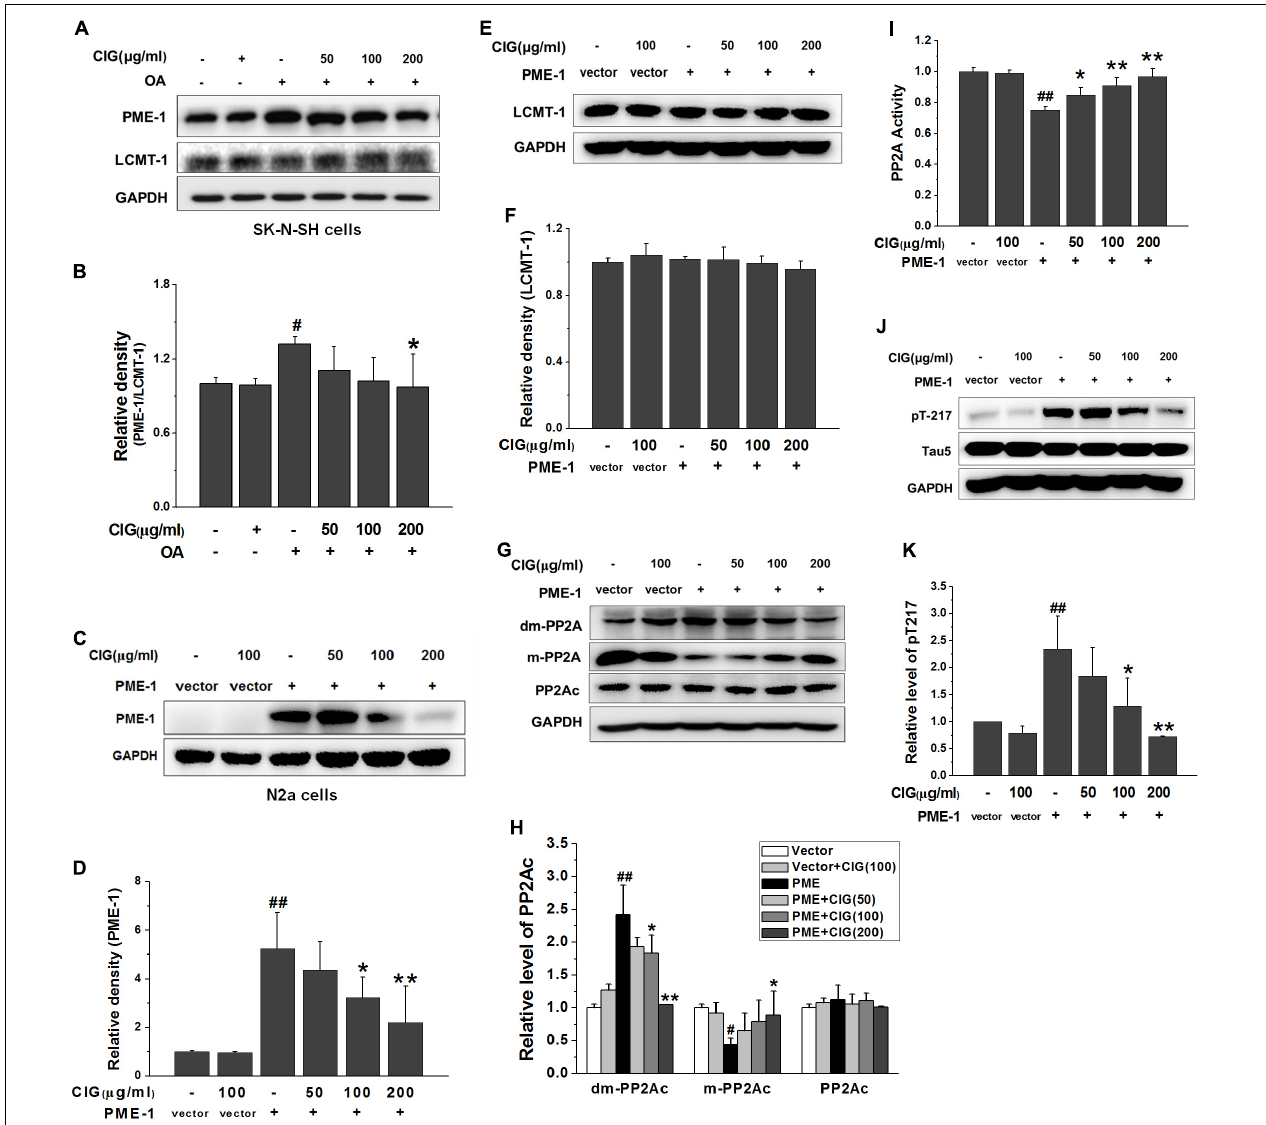
FIGURE 5 | Cornel iridoid glycoside inhibits demethylation of PP2Ac via decreasing PME-1. (A,B) The expression of PME-1 and LCMT-1 in OA-treated SK-N-SH cells, and the ratio of PME-1/LCMT-1. (C,D) The expression of PME-1 in mouse neuroblastoma N2a cells transduced with PME-1 genetic materials delivered by recombined lentivirus vector. CIG was incubated with the transduced cells for 24 h. (E,F) The expression of LCMT-1 in N2a cells transduced with PME-1 genetic materials. (G,H) The expression of demethylated PP2Ac (dm-PP2Ac) and methylated PP2Ac (m-PP2Ac). (I) The activity of PP2A measured by a biochemical assay, n = 6 per group. (J,K) The phosphorylation of tau at Thr217 (pT217). GAPDH was used as an internal control, and the expression level of control group was set as 100%. Data are expressed as mean ± SD; n = 3–4 each group. # P < 0.05, ## P < 0.01, the model group compared with the control group; ∗ P < 0.05, ∗∗ P < 0.01, drug groups compared with the model